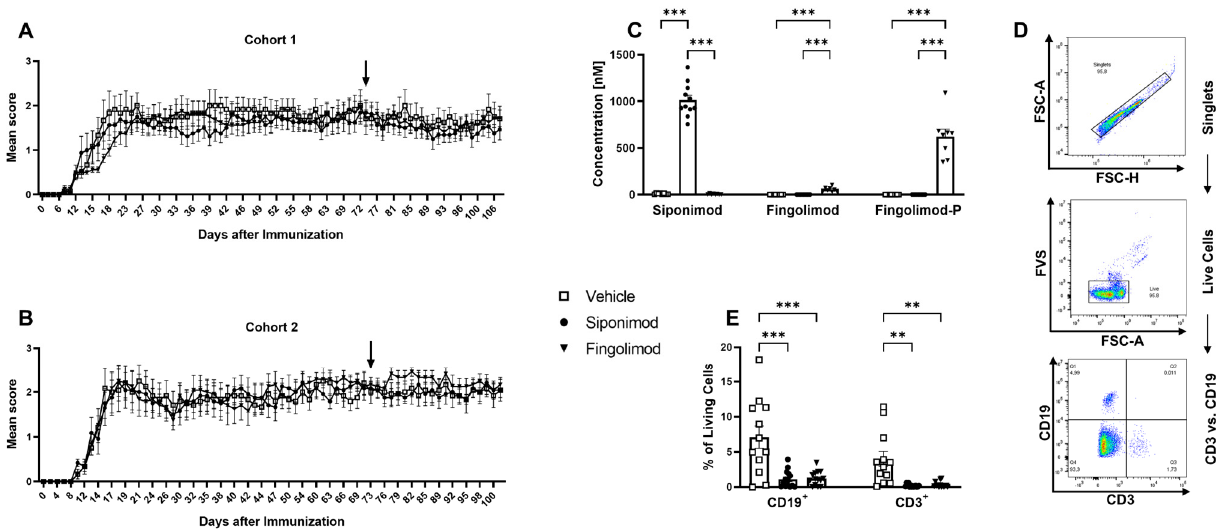
Figure 1. Development of experimental autoimmune encephalomyelitis in different treatment cohorts and validation of treatment success. Female C57BL/6J mice (9–12 weeks old) were immunized with MP4. ( A , B ) Disease course in two independent EAE cohorts. Arrows mark the beginning of siponimod or fingolimod treatment. ( C ) Thirty days after treatment initiation, serum samples were analyzed using mass spectrometry to determine siponimod, fingolimod, and fingolimod phosphate (fingolimod-P) concentrations. ( D ) Gating strategy for flow cytometry analysis of whole blood 30 d after treatment onset, which is shown in ( E ). Forward scatter height (FSC-H) vs. forward scatter area (FSC-A) was used to identify singlets. A fixable viability stain (FVS) was used to exclude dead cells. CD3 vs. CD19 comparison showed T (CD3 + , CD19 − ), B (CD3 − , CD19 + ), double negative, and double positive cells. Statistical analysis was performed using two-way ANOVA. ** p < 0.01; *** p < 0.001. EAE = experimental autoimmune encephalomyelitis, fingolimod- P = fingolimod phosphate, FCS-A = forward scatter area, FSC-H = forward scatter height, FVS = fixable viability stain, ANOVA = analysis of variance. 2.2. The Enteric Nervous System Expresses Sphingosine-1-Phosphate (S1P) Receptors MP4-induced EAE has been shown to manifest not only in the CNS, but also in the ENS, and ENS damage occurred even before the onset of the clinical signs of EAE [23]. To evaluate the potentially protective effect of siponimod on the ENS, a primary culture of enteric neurons and glial cells was established. The protocol was based on Smith et al. [33] and optimized for use with the Miltenyi gentleMACS TM Octo Dissociator. To this end, the longitudinal muscular layer, with the attached myenteric plexus (LMMP), was removed from the complete intestine (from duodenum to rectum) and digested enzymatically and mechanically (Figure 2A). After 10 d in culture, a stable network of interacting cells was visible using light microscopy (Figure 2B). Immunofluorescence staining revealed the expression of typical enteric glial and neuronal markers—glial fibrillary acidic protein (GFAP) and β III-tubulin, respectively. Interestingly, clearly separated neuron and glial cell staining, positive for only one of the markers, were only observed immediately after preparation until day 3 in culture. From day 5 onward, cells coexpressing GFAP and β III- tubulin were present. Coexpression decreased from day 10 onward, increasing the proportion of β III-tubulin single positive cells (Figure 2C). This observation is in line with Verìssimo et al., who reported that ex vivo isolated enteric glial cells could differentiate into neurons in culture [34].